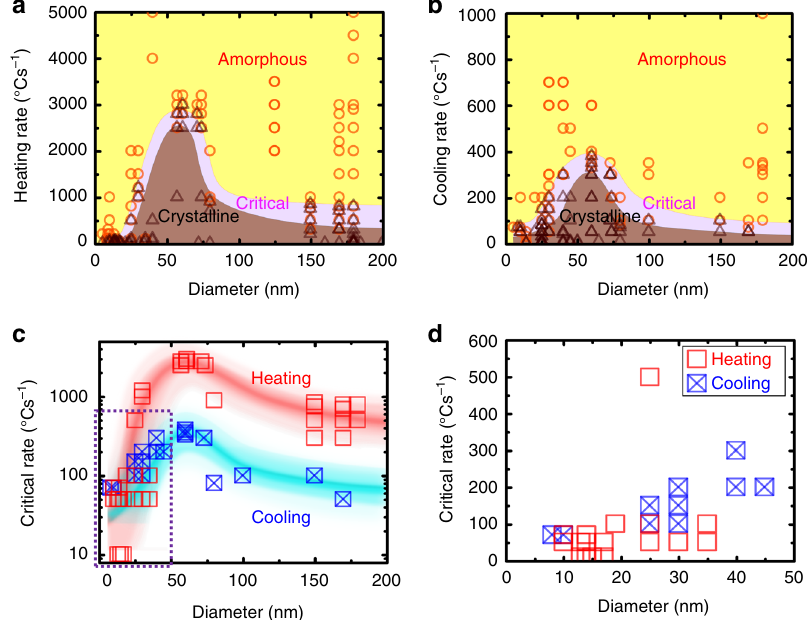
Fig. 2 Summary of in situ TEM heating and cooling experiments for all considered nanorods. a Diameter-dependent critical heating rates of MG nanorods. b Diameter- dependent critical cooling rates of MG nanorods. Summary of the in situ TEM critical heating ( a ) and cooling ( b ) rate experiments as a function of the rod diameter. Each rod was repeatedly heated or cooled with varying rates to identify the critical rates. Orange circles indicate no observation of crystalline phases while the brown triangles indicate occurrence of crystalline phases during heating ( a ) or cooling ( b ). The regions shaded in yellow indicate that no clear crystalline phases were detected during the heating ( a ) and cooling ( b ) cycles. The regions shaded in brown indicate that crystalline phases were observed in all heating ( a ) and cooling ( b ) cycles. The critical heating ( a ) and cooling ( b ) ranges are marked in purple. c , d Critical heating and cooling range extracted from a and b . c The red and blue curves represent the fi tted critical heating and cooling rates, respectively. The critical heating and cooling curves are fi tted by the local regression model using R software. The shaded areas in red and blue indicate the scatter in the measurements of the critical rates, which re fl ects the stochastic nature of crystallization. d Magni fi ed graph of the purple dotted rectangle in c , showing that the asymmetry